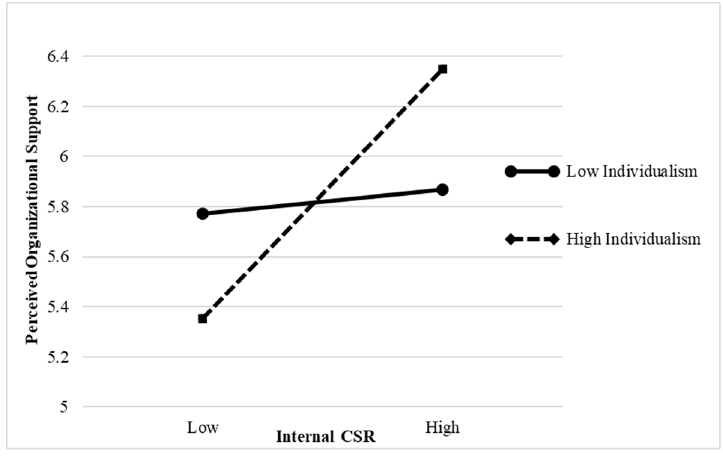
Figure 3. The interactive effect of internal CSR and individualism on perceived organizational support (POS).